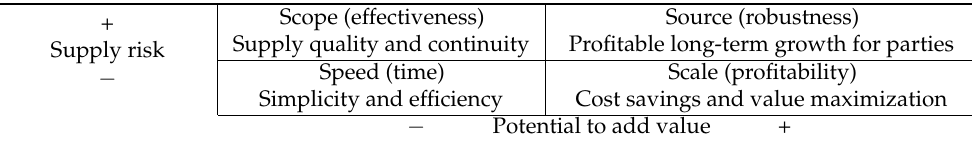
Table 6. Digital business strategy identification matrix (adapted from